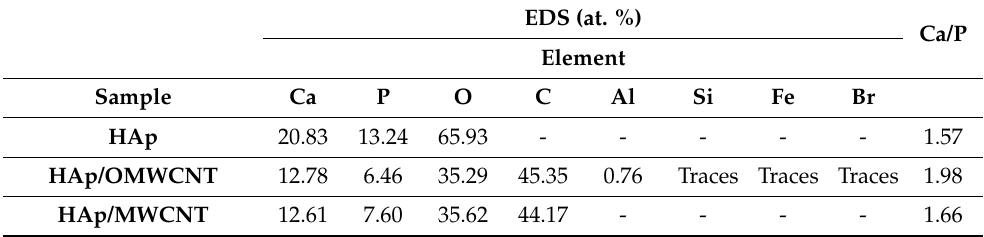
Table 3. Compositional analysis by EDS and Ca/P ratio of the three samples.